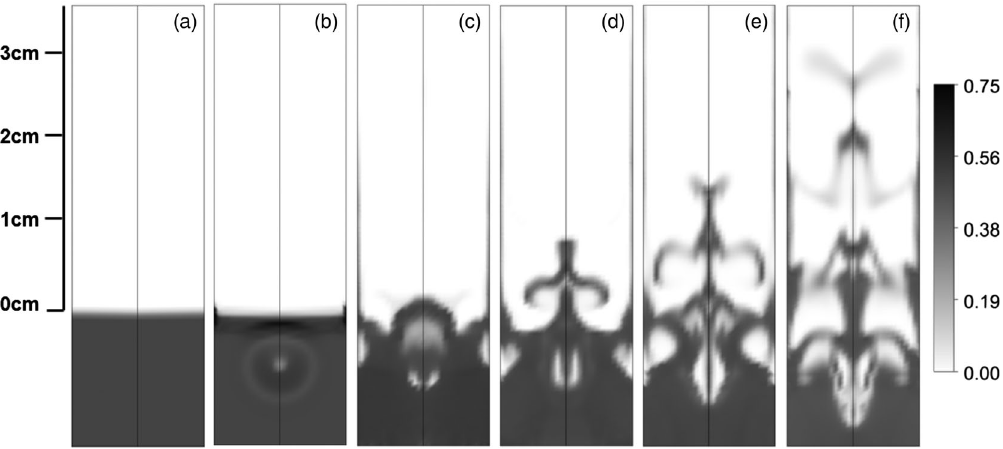
FIG. 17. Simulation of charge induced lift of 34 micron diameter tungsten particles, tungsten volume fraction at plane AA at indicated time intervals after a beam pulse with 3 × 10 12 protons; a ¼ 1 μ s, b ¼ 0 . 1 ms, c ¼ 1 ms, d ¼ 2 ms, e ¼ 3 ms, and f ¼ 5